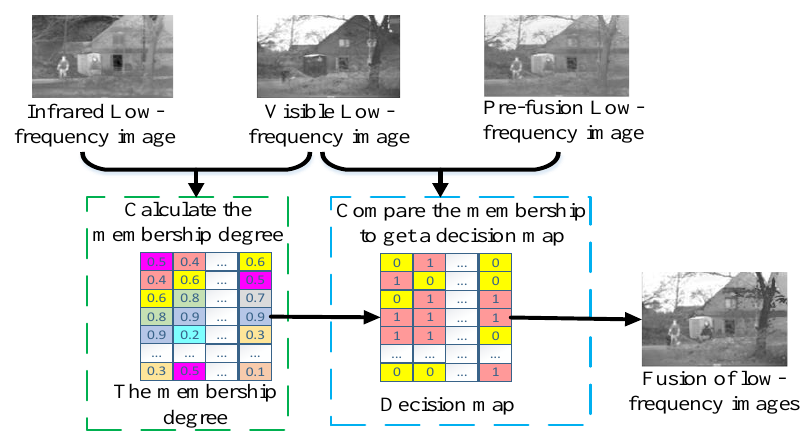
Figure 3. The fusion framework of the detailed layer. Gauss membership function is used to represent the membership degree of the coef- ficients, and the final low-frequency image is fused in accordance with the membership degree after defuzzification. The membership u IR and non-membership v IR of IR L